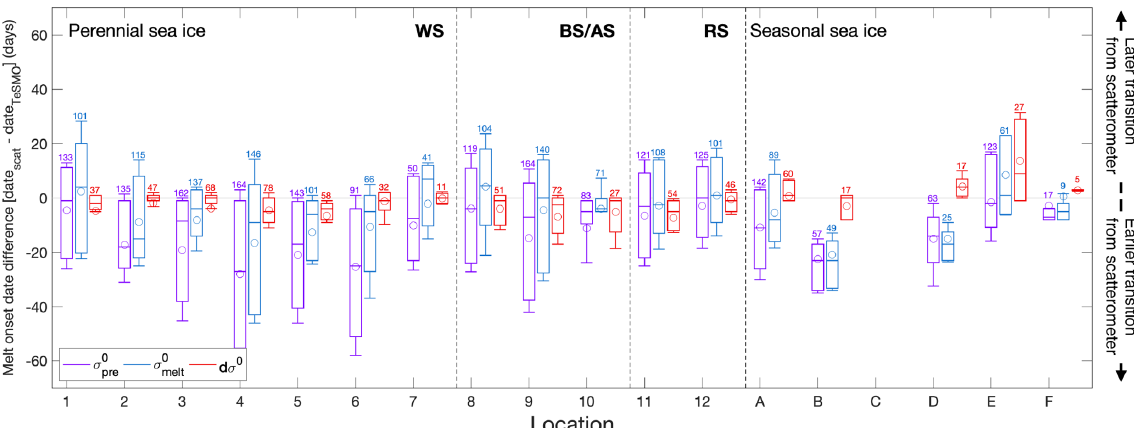
Figure 9. Mean time differences between retrieved snowmelt onset dates from scatterometer observations ( σ 0 pre , σ 0 microwave observations (Temporary Snowmelt Onset, according to Arndt et al., 2016) for all study locations. Snowmelt onset dates from passive microwave observations and backscatter time series are retrieved from 1992 to 2014/15, while the retrieval of diurnal backscatter variations d σ 0 is only performed with QSCAT from 2000 to 2008. Positive (negative) differences indicate a later (earlier) transition observed by scatterometers. Boxes are the first and third quartiles. Whiskers display the 20th and 80th percentiles. Circles indicate the mean, dashes the median. Numbers above the whiskers indicate the respective sample size. The maximum sample size for derived pre-melt and melt onset dates is 207, while it is 81 only for the melt onset retrieved from diurnal variations. Abbreviations are according to Fig. 1: WS – Weddell Sea, BS/AS – Bellingshausen and Amundsen seas, RS – Ross